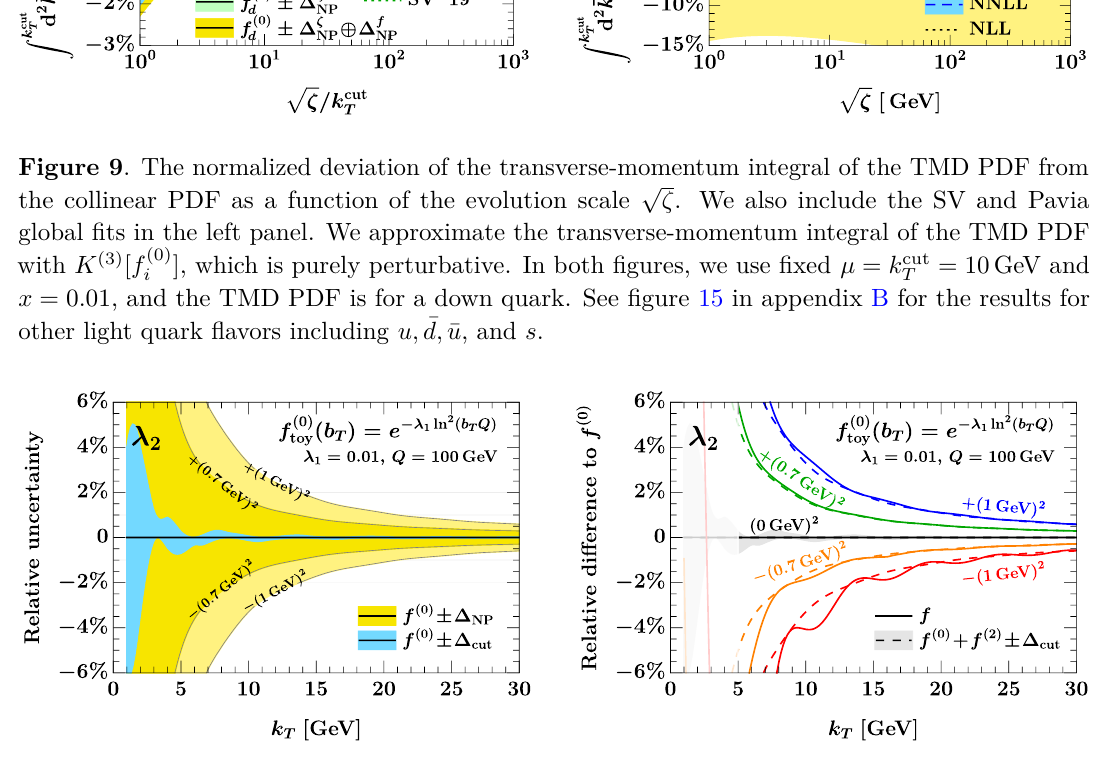
Figure 10 . Impact plots of quadratic “OPE” parameters in the toy function in eq. (2.25) interpreted as nonperturbative uncertainties (left) or fits to data (right). We consider the impact of the “nonperturbative” parameter λ 2 on the toy model in eq. (2.22) with the expansion in eq. (2.25). To produce “data” (solid lines on the right) for coefficients λ 2 > 0 , where the original definition has a divergent Fourier transform, we have modified the toy function as described in the text, see eq. (4.2). We use a third-order functional S (3) throughout. The innermost uncertainty bands in light blue or gray, respectively, indicate ∆ cut , which for clarity is only shown for λ 2 = 0 in the right panel.